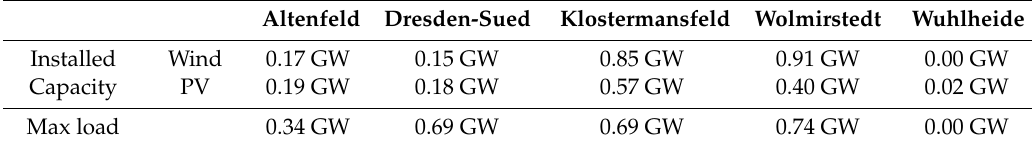
Table 4. Installed RE capacity and load situation of the example substations in